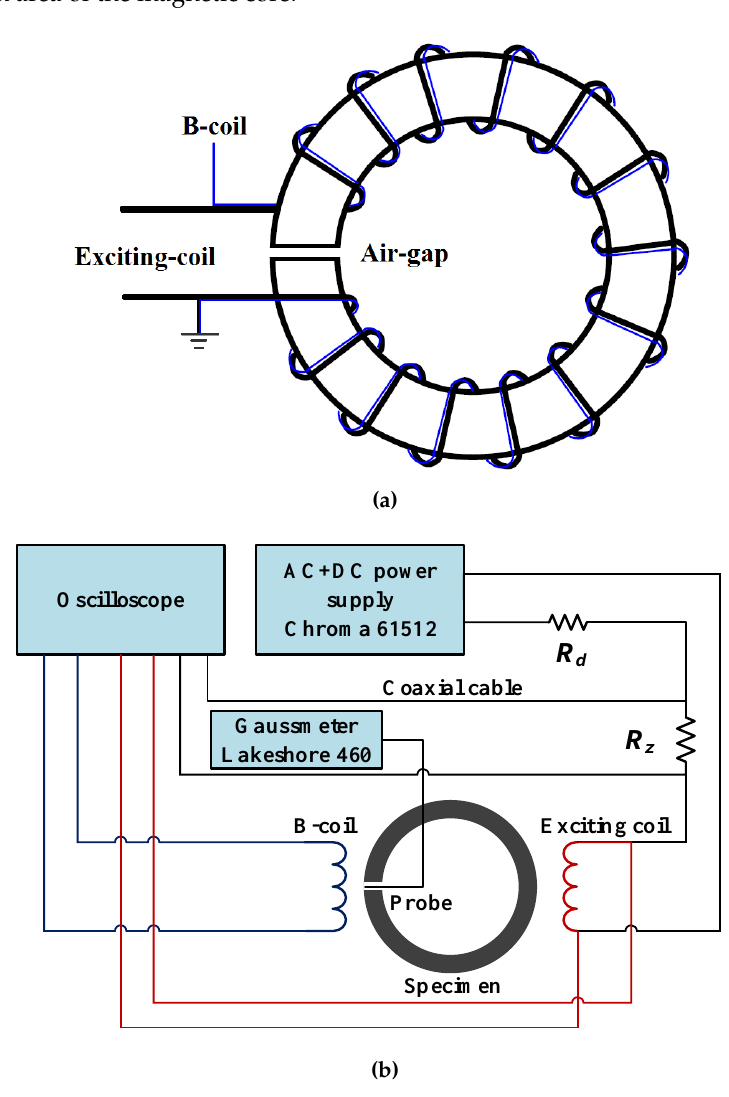
Figure 1. Setup of the specimen and experimental system. ( a ) Arrangement of the specimen; ( b ) Schematic diagram of the experimental